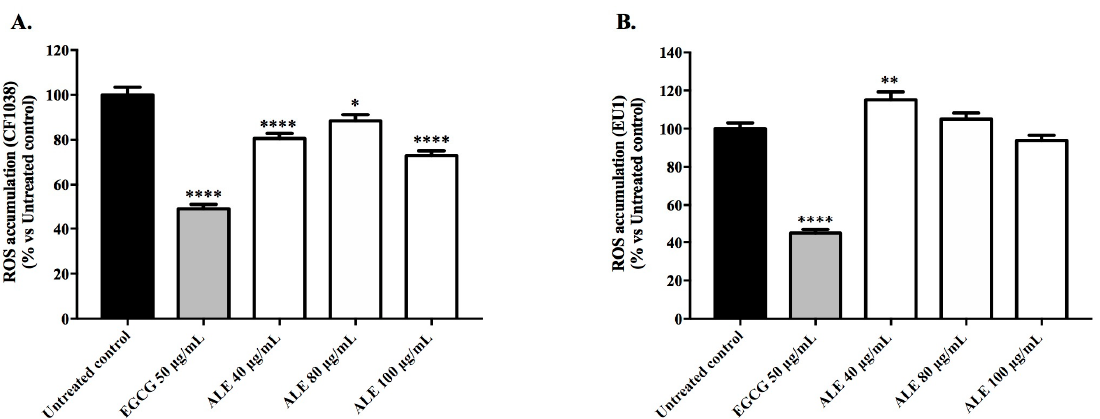
Figure 5. Intracellular ROS accumulation in the mutant worms treated with Uncaria tomentosa leaf extract under physiological conditions, showing the following: ( A ) mutant worms lacking daf-16 (CF1038) and ( B ) mutant worms lacking skn- 1 (EU1). The control groups were the untreated worms and those pre-treated with EGCG at 50 µg/mL. Each bar represents the mean value ± SEM from three independent assays. The asterisks indicate the statistical differences in relation to the untreated worms according to one-way ANOVA followed by a post-hoc Tukey’s test: * p < 0.05, ** p < 0.01, and **** p < 0.0001.